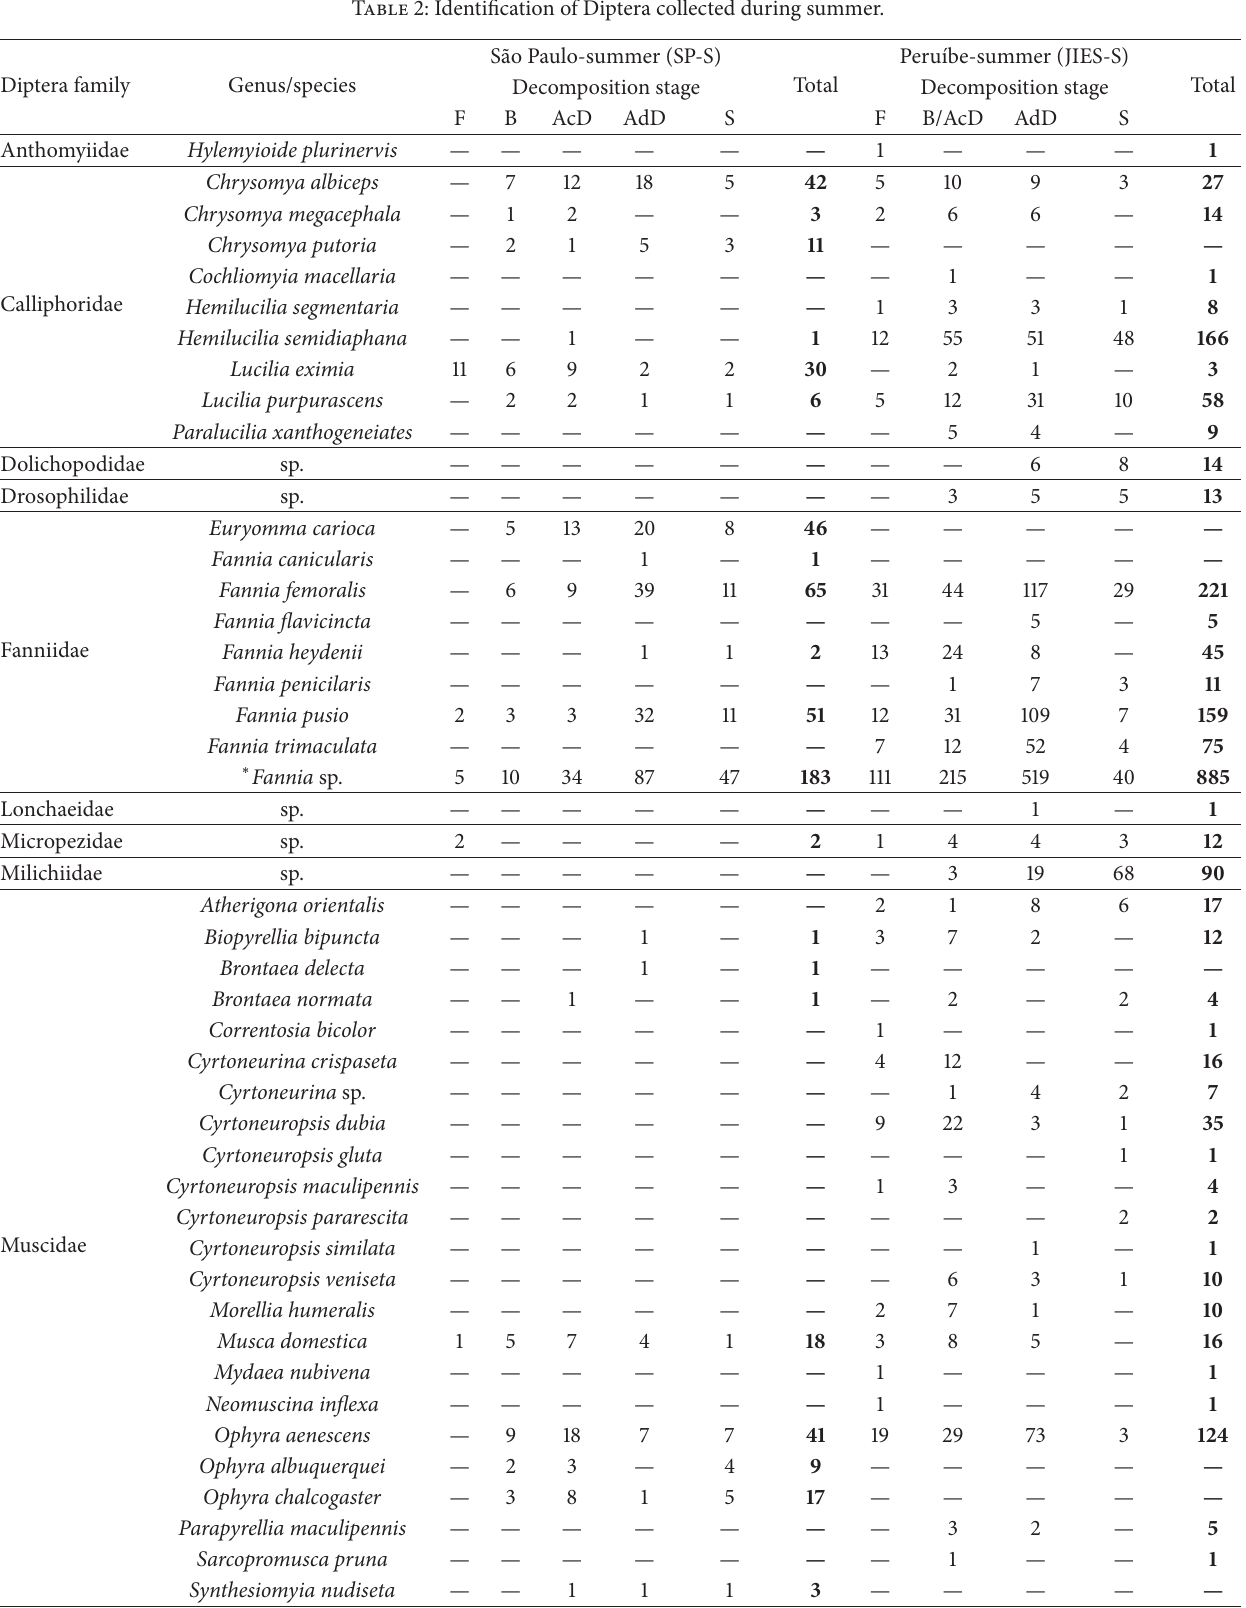
Table 2: Identification of Diptera collected during